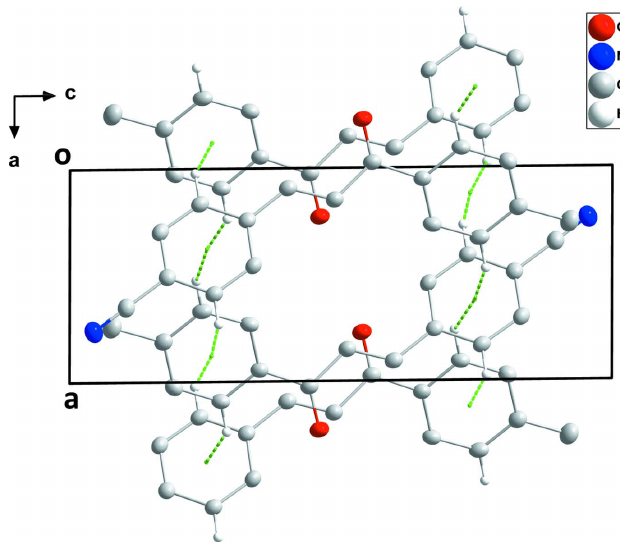
Figure 1 The title molecule showing 30% probability